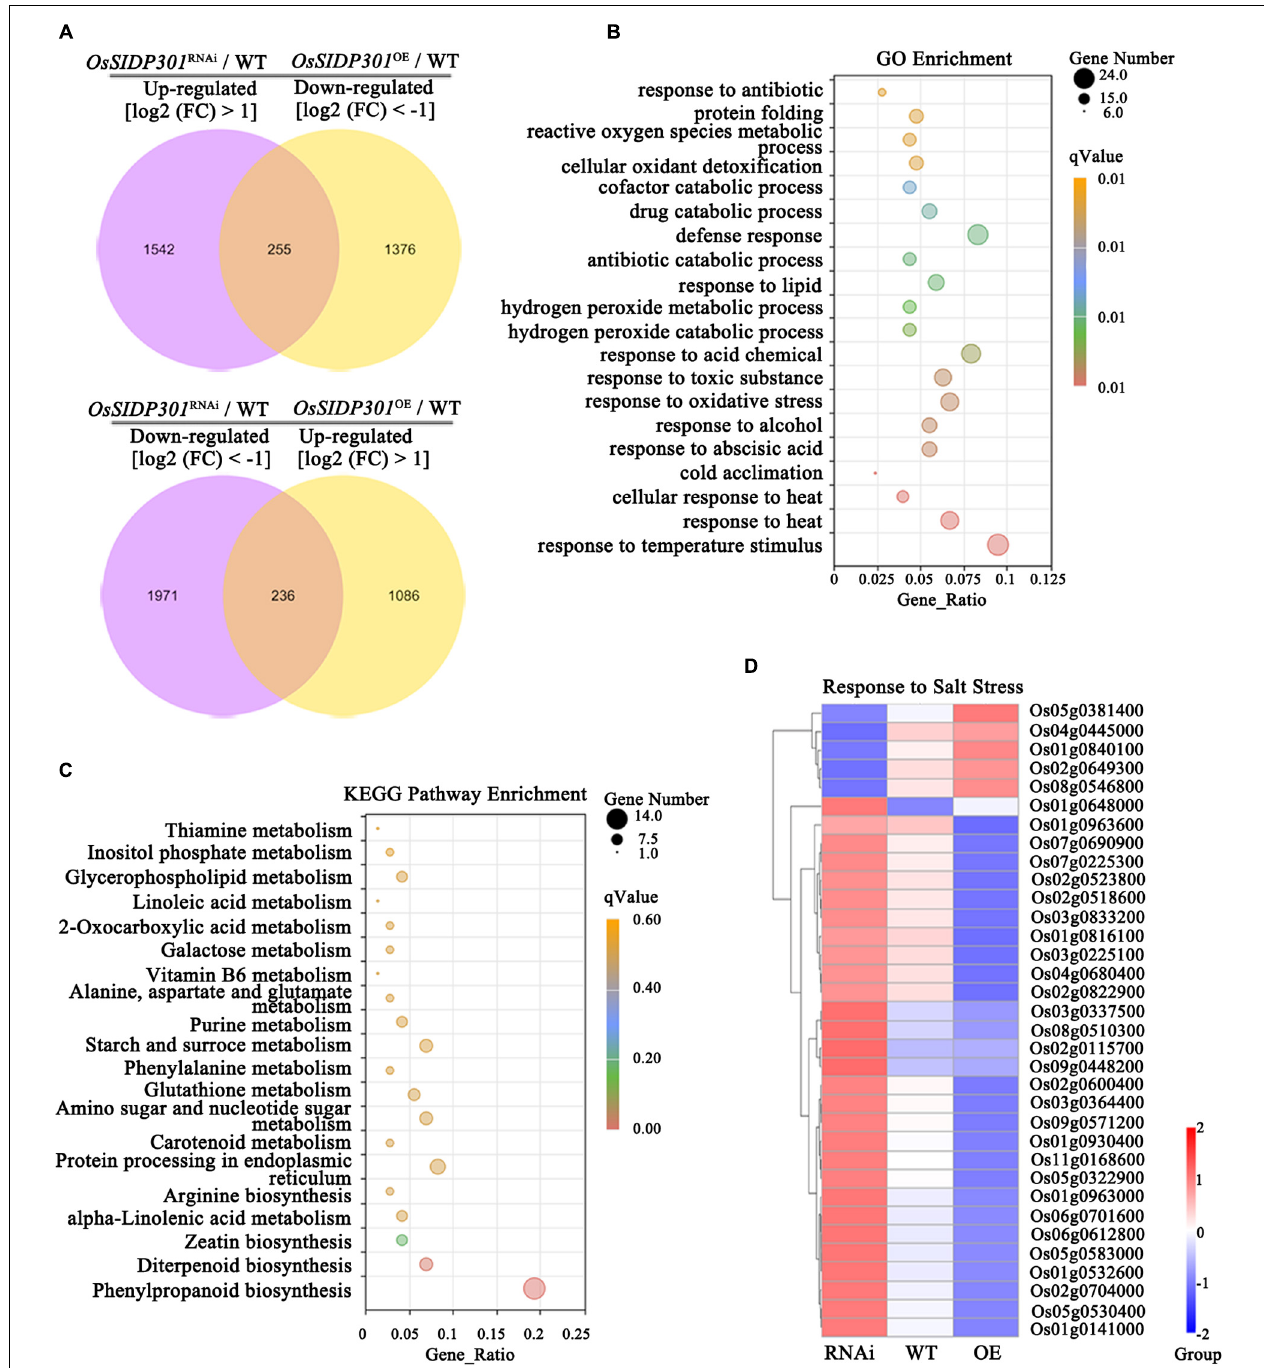
FIGURE 6 | Transcriptome analysis of OsSIDP301 transgenic plants. (A) Venn diagrams for the upregulated in OsSIDP301 RNAi and downregulated in OsSIDP301 OE DEGs, and downregulated in OsSIDP301 RNAi and upregulated in OsSIDP301 OE DEGs with NaCl treatment. (B) Gene Ontology (GO) enrichment analysis of the (A) DEGs. (C) Kyoto Encyclopedia of Genes and Genomes (KEGG) enrichment analysis of the (A) DEGs. (D) Heatmaps showing the partially representative salt-related gene expression patterns between WT and transgenic plants under salt stress.